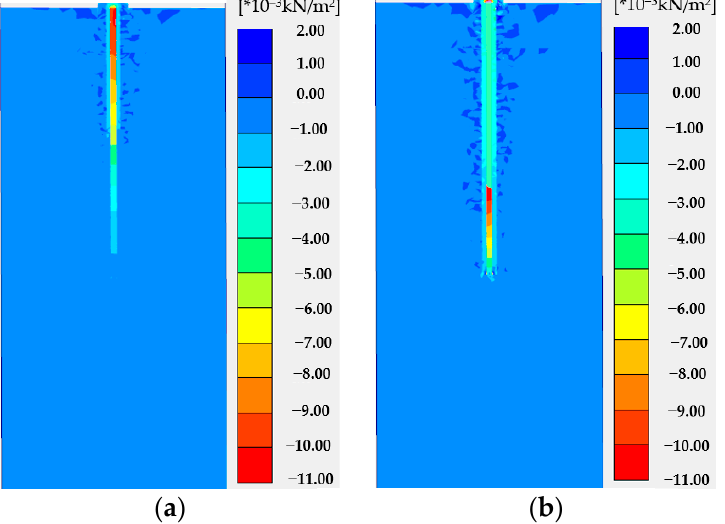
Figure 9. Stress distribution of pile: ( a ) loading to 1650 kN; ( b ) loading to 3300 kN.